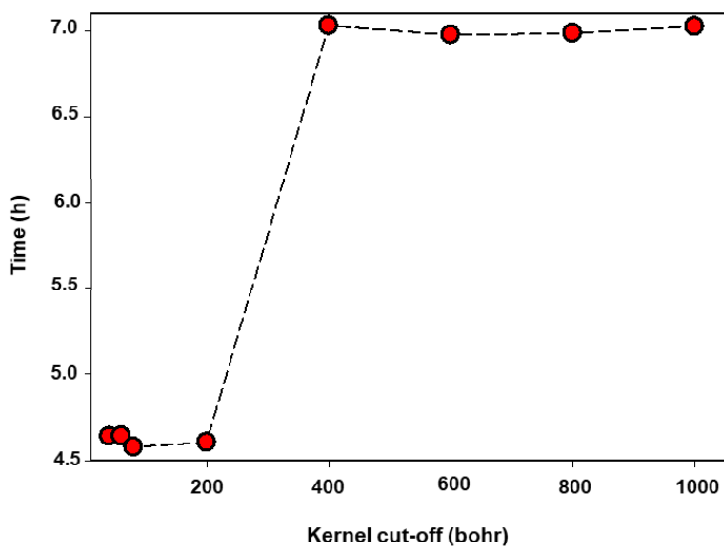
Figure 11. Investigation of the effect of kernel cut-off for a 1296 atoms Mn 2 O 4 spinel structure on total computational time.